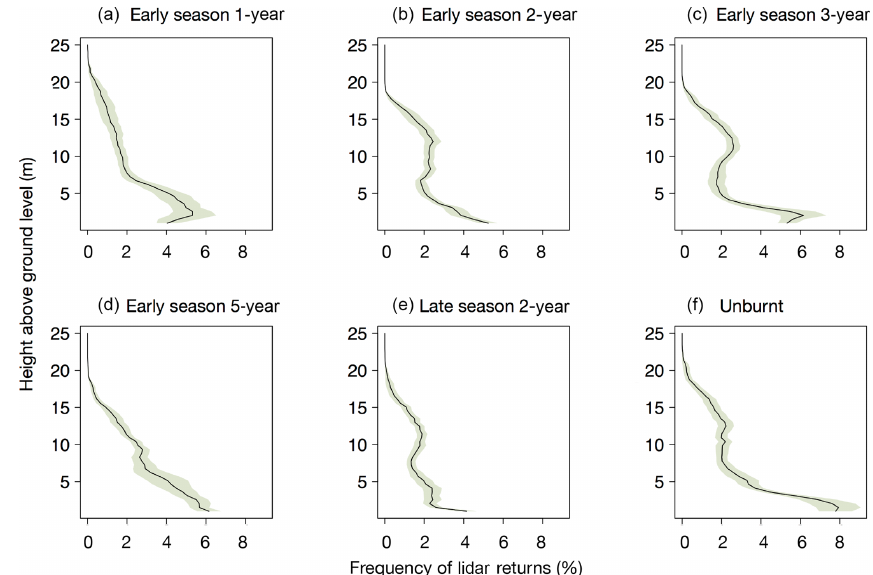
Figure 6. Effects of fire regime on vertical habitat structure determined from the frequency of airborne lidar returns. Solid black lines are the mean frequency distribution of lidar returns, and the green bands indicate the 95% confidence interval.